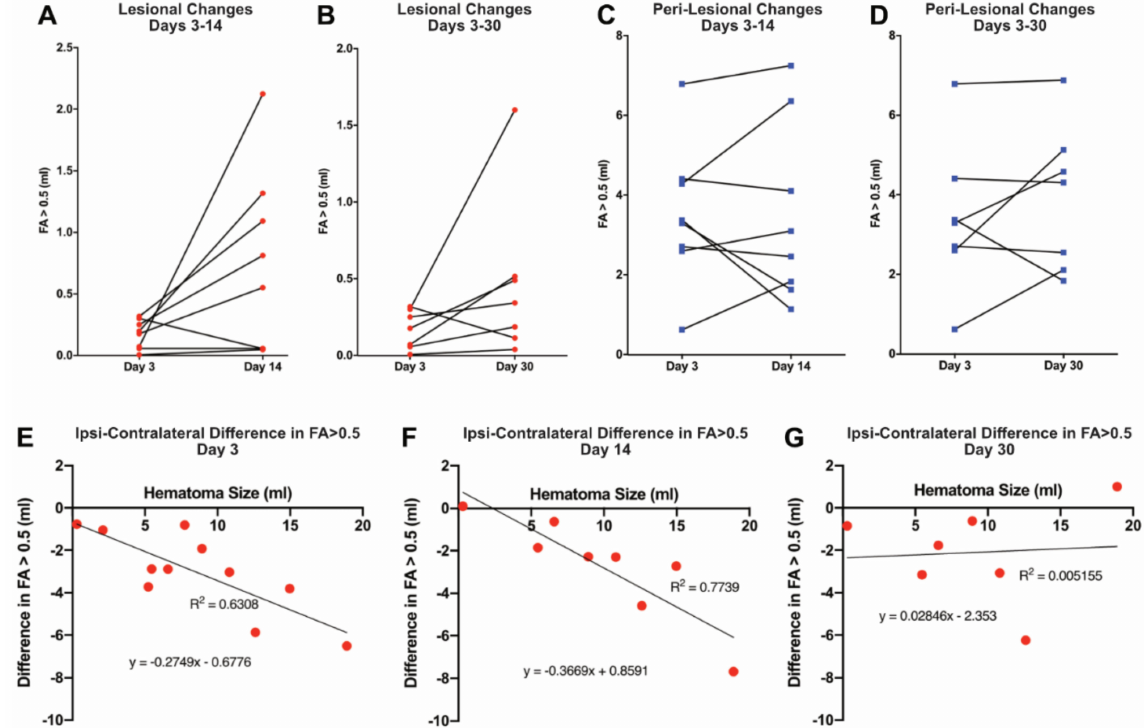
Figure 3. ( Upper panel ) Temporal profile of intracerebral hemorrhage-induced injury in patients who received multiple scans. The graphs show changes in the volume (milliliters) of tissue FA > 0.5 within the lesion between days 3 and 14 ( A ) and days 3 and 30 ( B ), and changes in the volume (milliliters) of tissue FA > 0.5 for the peri-lesion between days 3 and 14 ( C ) and days 3 and 30 ( D ). There was no statistical significance between the volume of tissue FA between any of these days ( A : p = 0.061, B : p = 0.153, C : p = 0.961, D : p = 0.351; paired t -tests, two-tailed). ( Lower panel ) Effect of hematoma size on intracerebral hemorrhage-induced white matter injury. Contralateral FA > 0.5 tissue was used to obtain the expected amount (milliliters) of perilesional FA > 0.5 tissue and, from the measured amount of perilesional FA > 0.5 tissue, to calculate the amount (milliliters) lost (see Methods). Perilesional tissue loss is shown at days 3, 14, and 30 ( E , F , and G , respectively) plotted against hematoma volume (milliliters) at day 3. The amount of FA > 0.5 tissue loss was significantly correlated with hematoma size at days 3 ( p < 0.01) and 14 ( p < 0.01), but not at day 30 ( p = 0.878). Two patient data points are absent from graphs F and G , as these patients did not have the initial hematoma size at day 3 available for